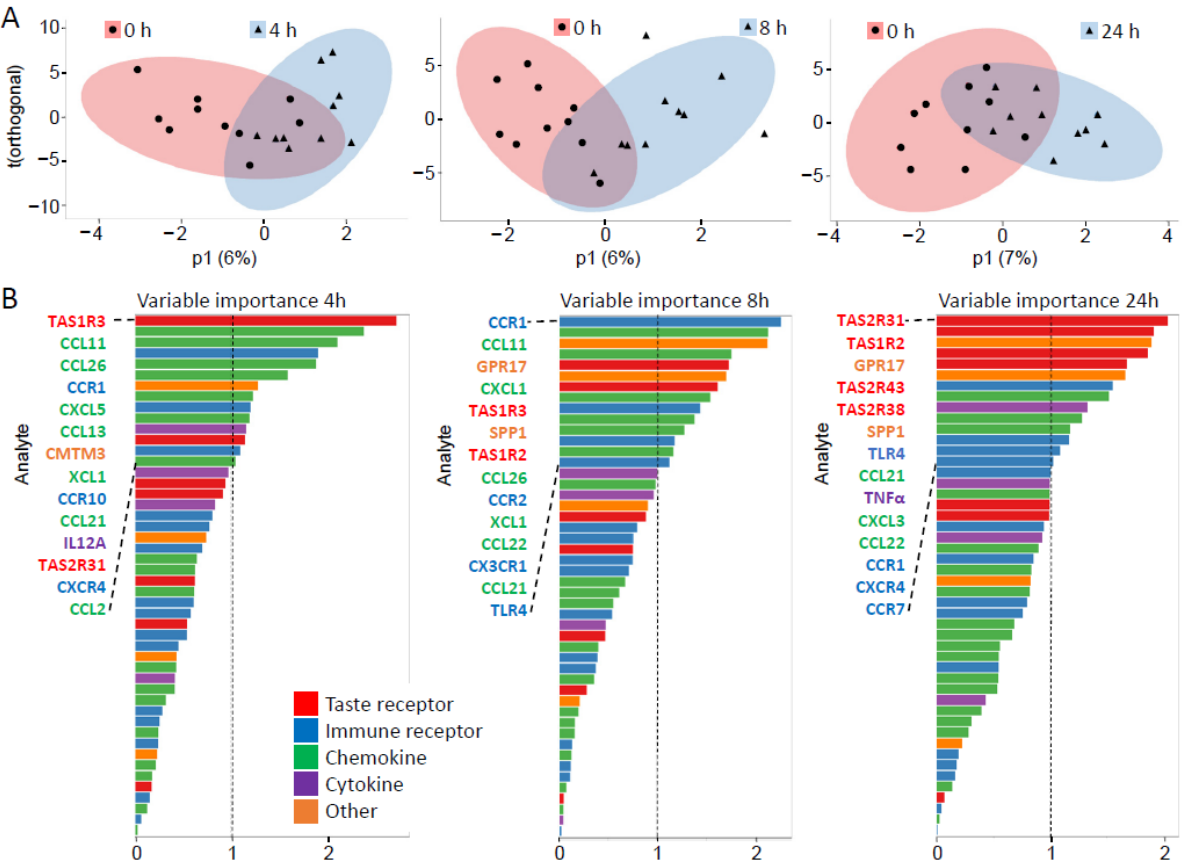
Figure 6. The OPLS-DA and VIP score plots of transcriptional data between sweetener mix and water in healthy volunteers. ( A ) Group differences at increasing post-prandial times are illustrated with OPLS-DA score plots. The figure illustrates the effect of the different intervention times after consumption of the sweetener mix (filled red circles) vs. pre-intervention (filled blue triangles). Each point matches a single volunteer. Multivariate differences between groups are modeled to the effect of treatment, while variation unrelated to the treatment is modeled on the orthogonal component ( y -axis; t(orthogonal)) and represents primarily individual differences. Between-group differences related to the intervention are modeled on the predictive component ( x -axis; p1). The ellipses around the grouped individuals give the 95% CI of the multivariate t-distribution of all features in the model. These calculations are based on changes over time in the RT-qPCR-derived transcriptional profile of isolated PMNs after intake of the sweetener surrogate beverage (Figure S2). ( B ) Variable importance in projection (VIP) plots of transcriptional data. The plots rank the 48 analyzed taste receptors, cytokines/chemokines, and their receptors, according to the variable importance scores at the time points 4, 8, and 24 h (post-intervention vs. 0 h). This analysis depicts the relevance of each analyte for the separation in the respective OPLS-DA-plot. Variables above the value of 1 are considered as